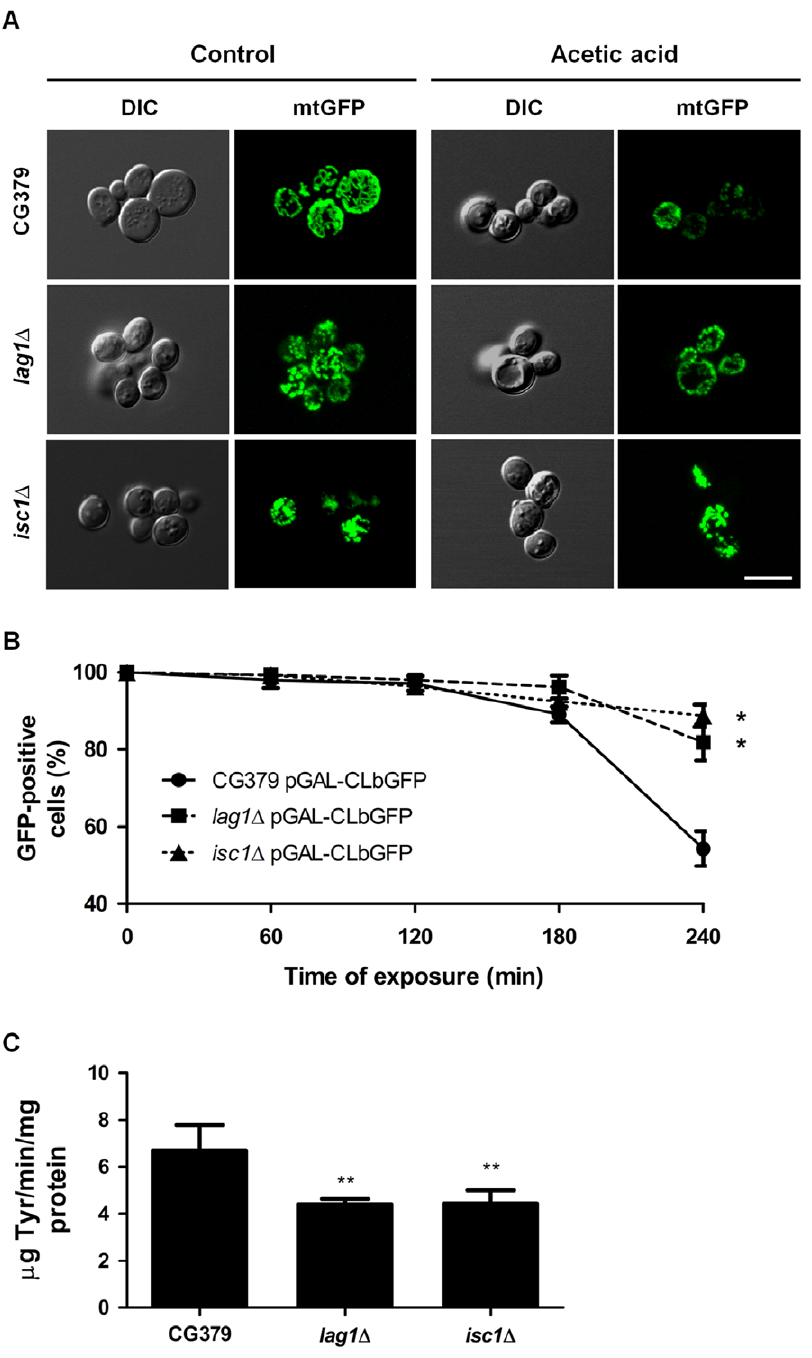
Figure 4. Mitochondrial morphology and degradation. (A) Analysis of mitochondrial morphology in S. cerevisiae strains CG379, lag1 D and isc1 D expressing mitochondrial GFP (pGAL-CLbGFP) before (control) and after exposure to 180 mM acetic acid, pH 3.0, for 200 min. Cells were observed by fluorescence microscopy. A representative experiment is shown. Bar, 5 m m. (B) Mitochondrial degradation was assessed in these strains by measuring the loss of mtGFP fluorescence during exposure to 180 mM acetic acid, pH 3.0, up to 240 min. (C) Pep4p activity was detected in extracts of the same strains, by measuring the release of tyrosine-containing acid- soluble peptides from acid-denatured haemoglobin. Values are mean 6 SD of at least three independent experiments. Values significantly different from CG379: * P , 0.05, ** P , 0.01, One-way ANOVA and Tukey Test.